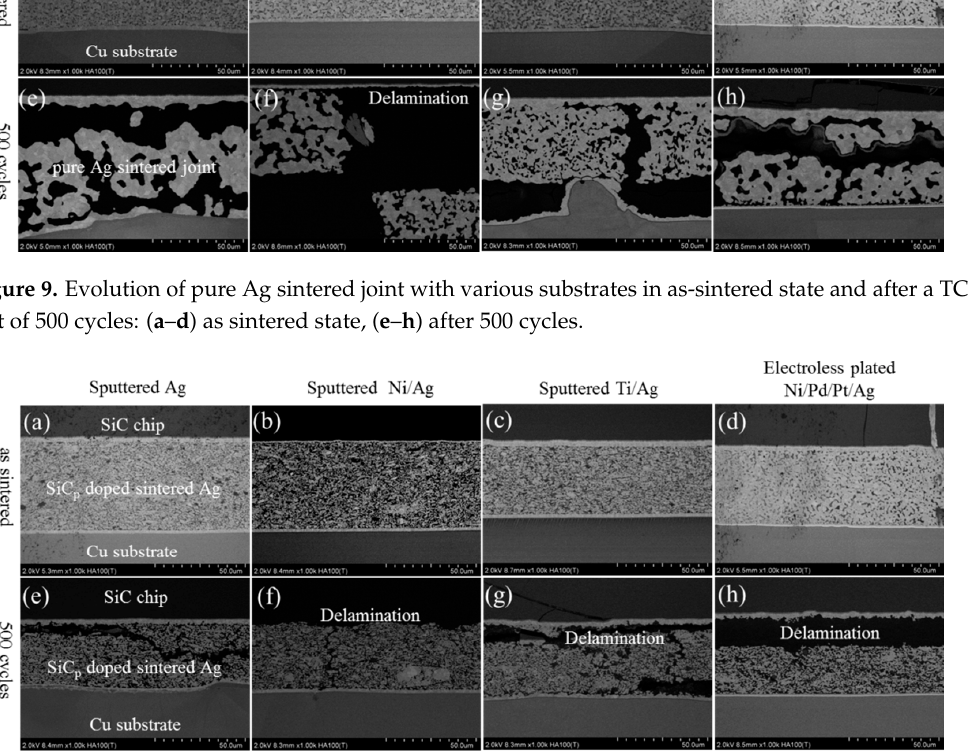
Figure 10. Evolution of SiC p doped Ag sintered joint with various substrates in as-sintered state and after TC for cycles: ( a – d ) as sintered state, ( e – h ) after 500 cycles.